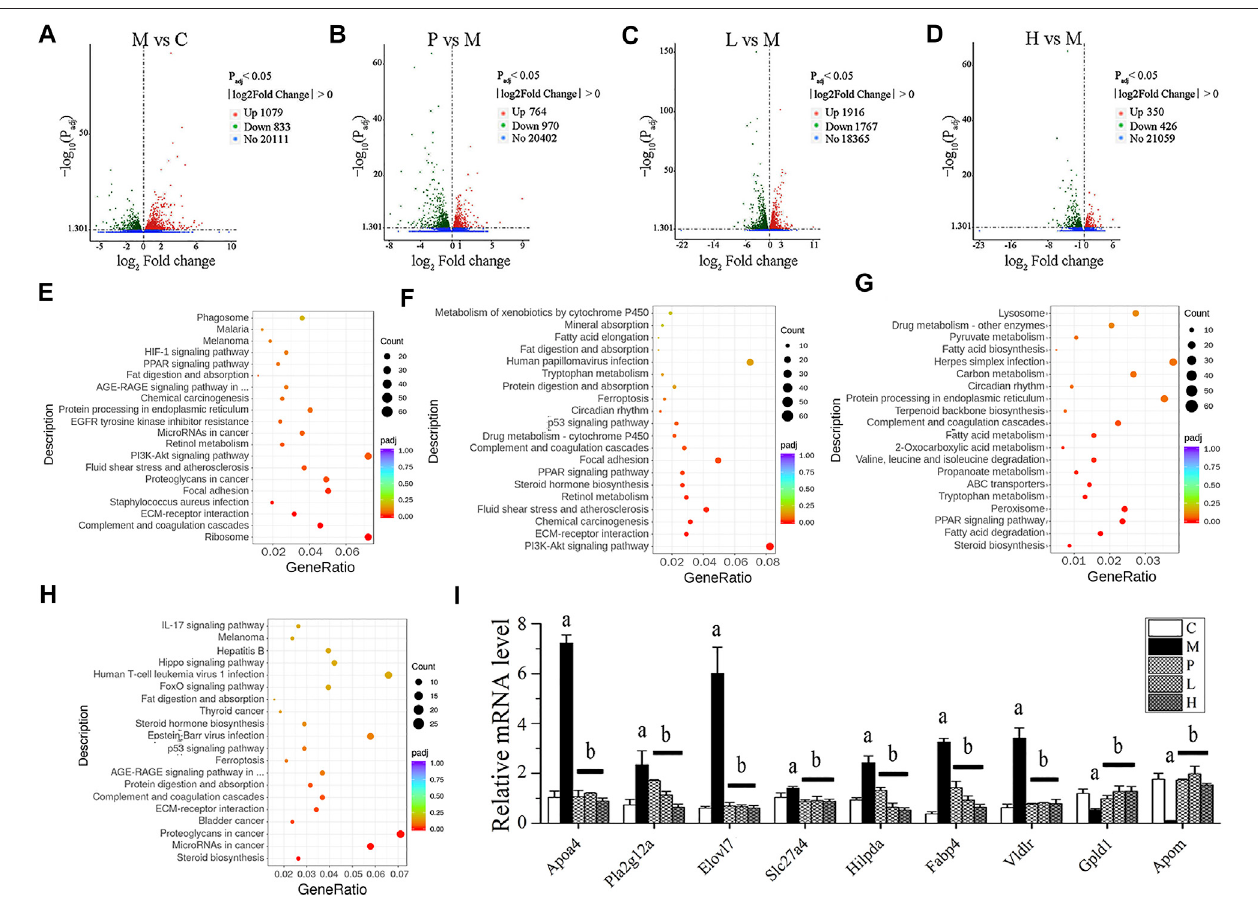
FIGURE 2 | Transcriptomic analysis of liver tissue. DEGs were displayed in volcano plot graphs [ (A) M vs. C; (B) P vs. M; (C) L vs. M; and (D) H vs. M] ( n = 3). The DEGswereenrichedintheKEGGpathwaydatabase[ (E) Mvs.C; (F) Pvs.M; (G) Lvs.M;and (H) Hvs.M]( n =3). (I) mRNAexpressioninliverswasdetectedbyreal-time PCR. (A) p < 0.01, compared with the C group; (B) p < 0.01, compared with the M